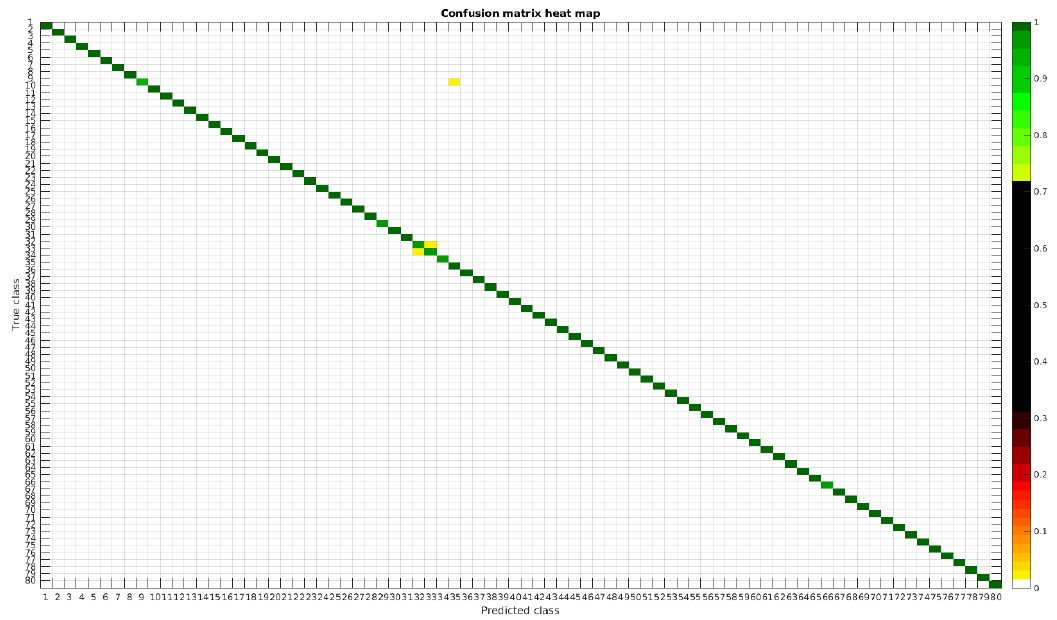
Figure 21. Confusion matrix heat map for the merged dataset with 2000 samples per class.